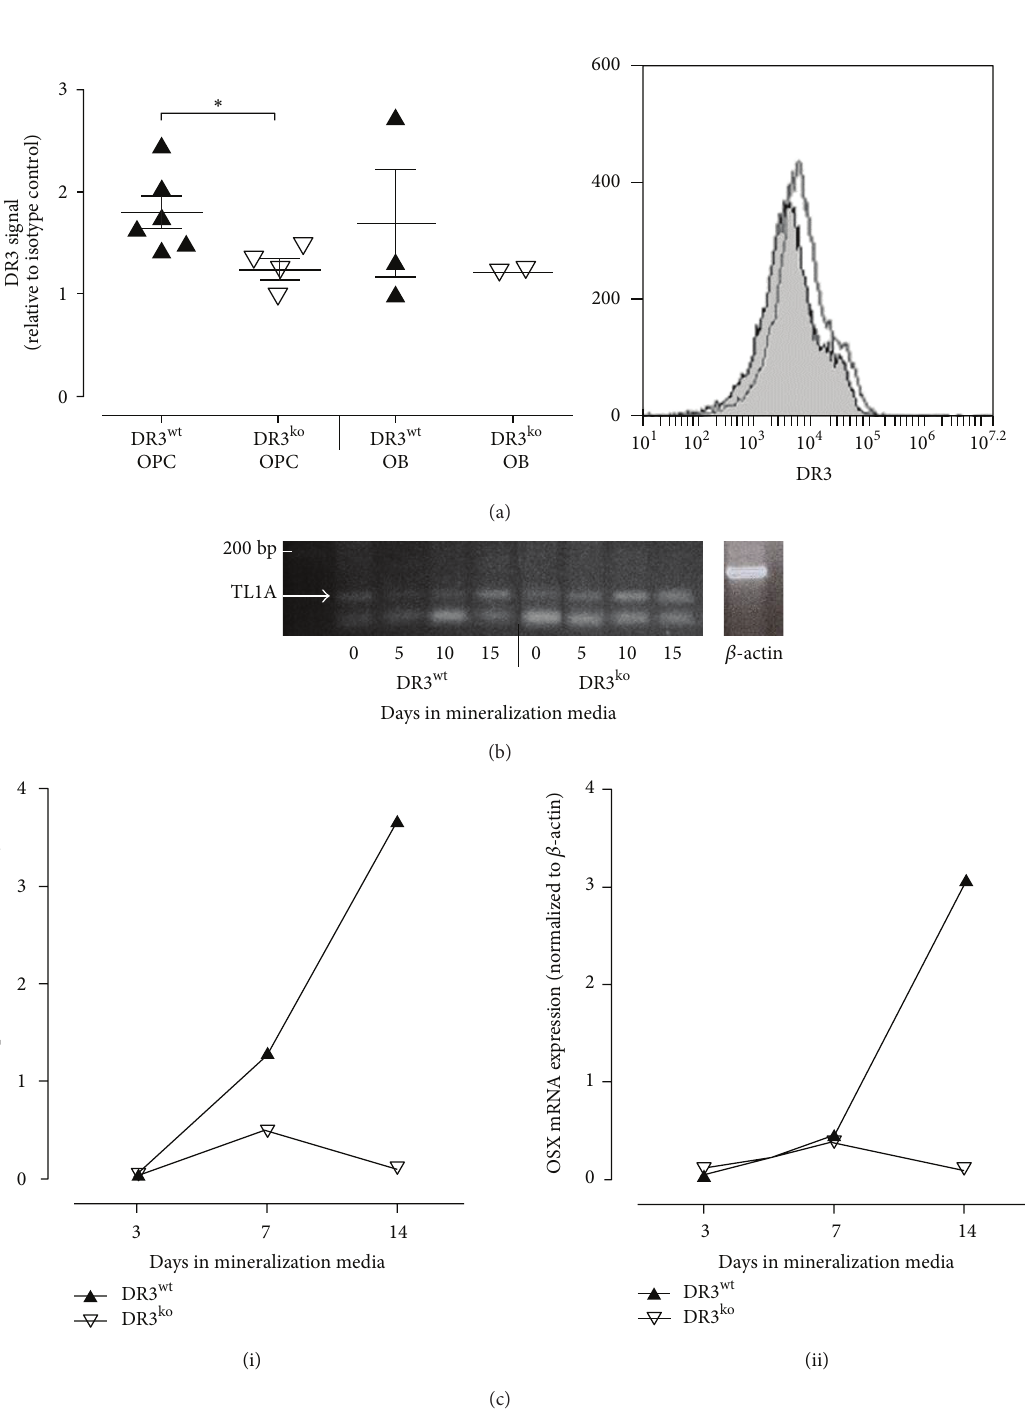
Figure 1: Expression of DR3 by murine OPCs and OBs. (a) DR 3 wt ( 𝑛 = 6 ) and DR 3 ko ( 𝑛 = 4 ) OPCs and OB (DR 3 wt 𝑛 = 3 , DR 3 ko 𝑛 = 2 ) were analysed for DR3 signal by flow cytometry. DR3 signal was observed on DR 3 wt OPCs and OBs. A small subpopulation of DR 3 wt OPCs displayed higher levels of DR3 signal (shaded area = isotype control, black outline = DR3 antibody). (b) RNA was extracted from DR 3 wt and DR 3 ko OPCs and OB and tested for TL1A mRNA by RT-PCR. A 91 bp band corresponding to TL1A mRNA was detected at all time-points demonstrating constitutive expression of TL1A mRNA by DR 3 wt and DR 3 ko OPCs and OB. (c) Samples (DR 3 wt 𝑛 = 1 , DR 3 ko 𝑛 = 1 ) were tested by qPCR at time points indicated to determine whether DR3 signalling modulates (i) Runx2 or (ii) OSX gene expression. Increased expression of Runx2 was detected at day 7 and day 14 while increased OSX expression was only detected at day 14 in the DR 3 wt compared to the DR 3 ko